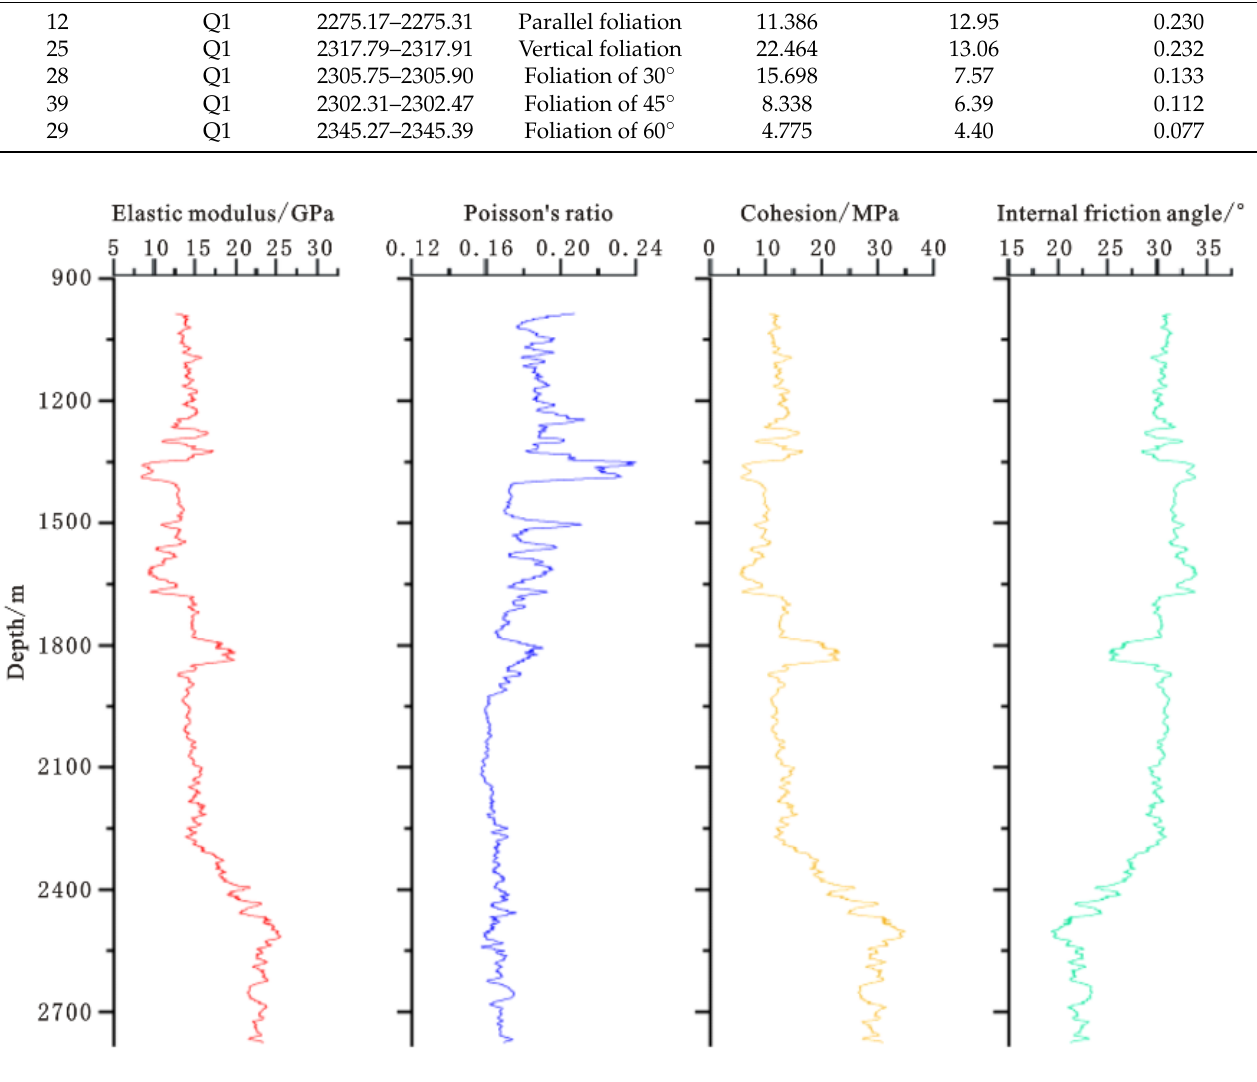
Figure 2. Rock mechanics parameter profile of Well GY2HC.